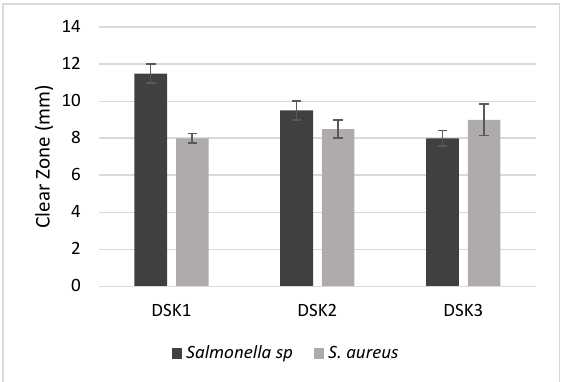
Figure 1. Antibacterial activity of bacteriocin ‐ producing candidates.